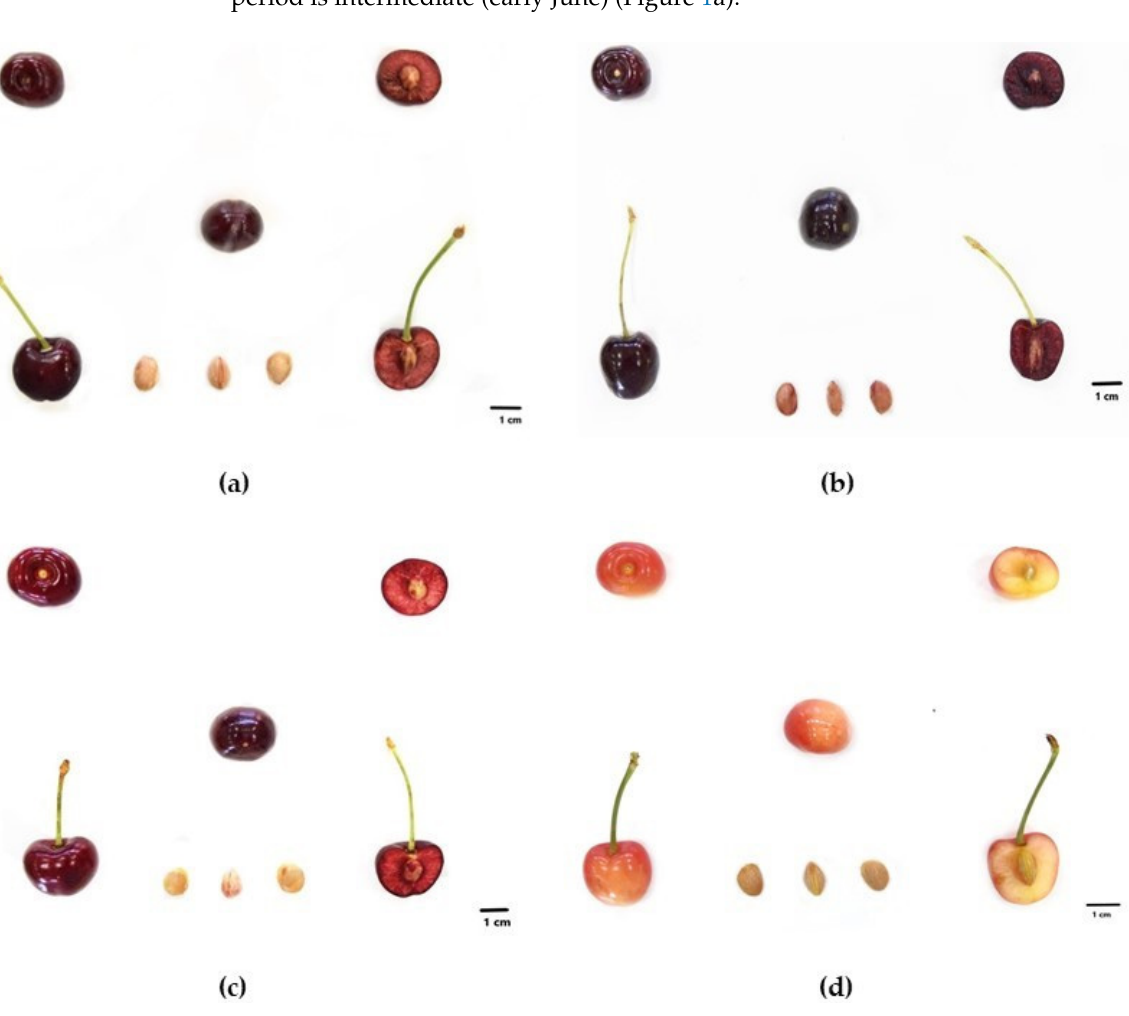
Figure 1. Agronomic details of whole fruit, fruit in cross and longitudinal section and seeds of Mulegnana Riccia ( a ), Mulegnana Nera ( b ), Montenero ( c ) and Limoncella ( d ).